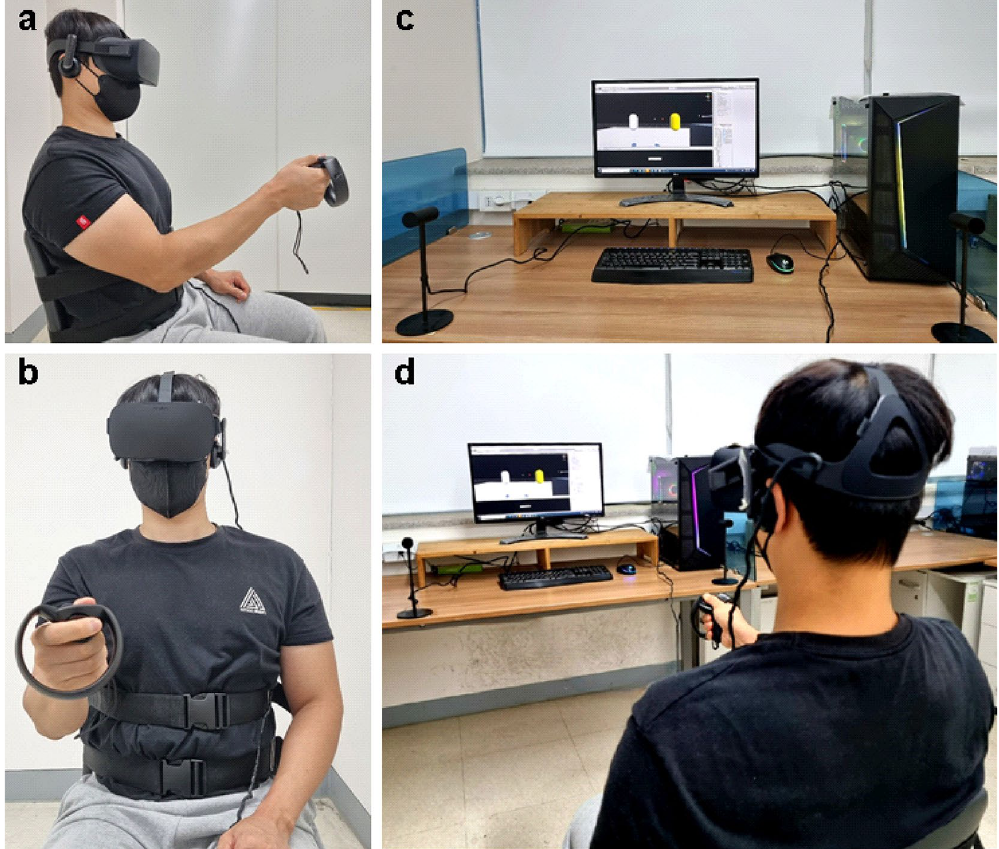
Figure 2. Experimental setup. ( a ) Side view of a participant seating on a fixed chair and wearing belts to fix their upper body positions. ( b ) Front view of the participant. ( c ) Experimental setup for VRRP task. ( d ) Back view of a participant performing VRRP